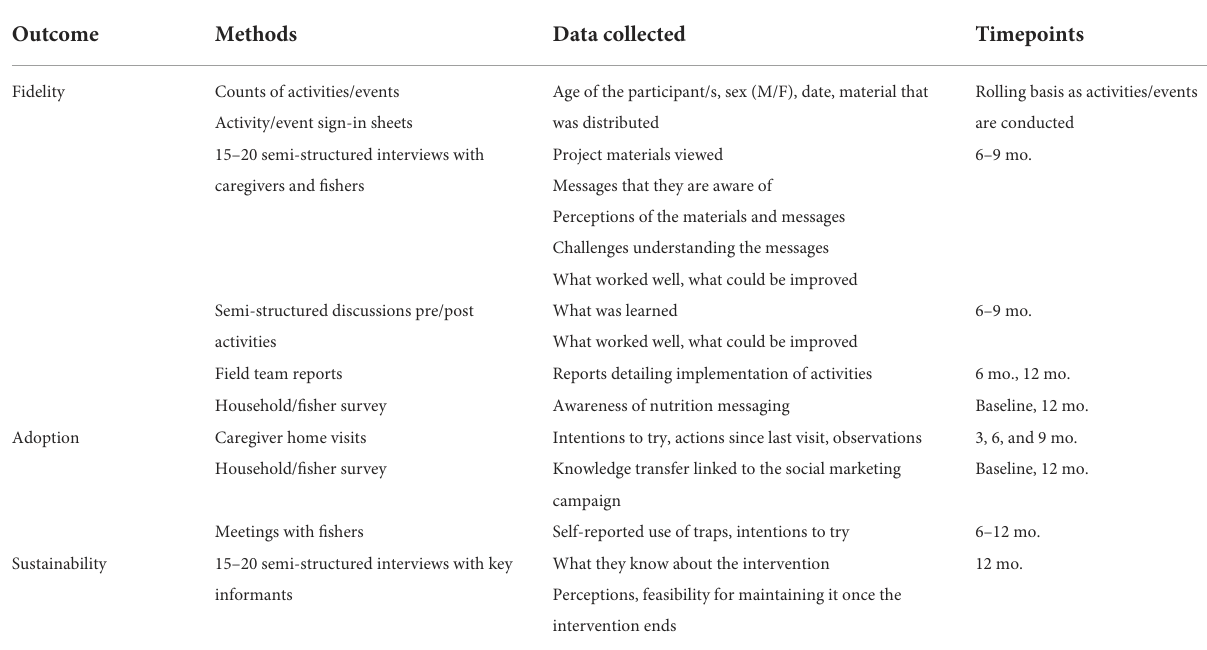
TABLE 6 Process evaluation